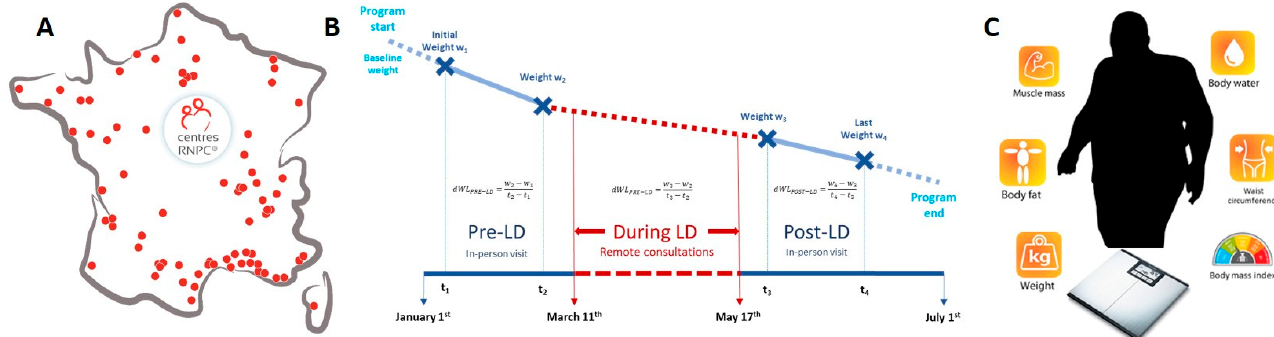
Figure 1. Study design and outcomes assessed in participants in a multicenter nationwide weight loss program. ( A ) Geographical distribution of the RNPC ® centers in France ( B ) Study design: data were prospectively collected at two time-points before and after the nationwide total lockdown (LD) due to Covid19 in France, during in-person appointments with a RNPC ® dietician. Remote consultations with the RNPC ® dietician were conducted by phone during the LD period. Median period durations between two measures: before lockdown (t 2 -t 1 ): 15 days [15; 17], during LD (t 3 -t 2 ): 99 days [92; 106], after LD (t 4 -t 3 ): 15 days [15; 21]—dWL: delta weight loss (dWL) for details regarding calculation of dWL, see “Outcomes and definitions”. ( C ) Data collection: at a face-to-face consultation with a dietician, measurements made using an impedance scale (the same Beurer BG42 calibrated bioelectrical device) for weight, muscle mass, fat mass and body water. Waist circumference was measured to the nearest cm at the natural waist. Body mass index was calculated by dividing the weight in kilos by the height squared.